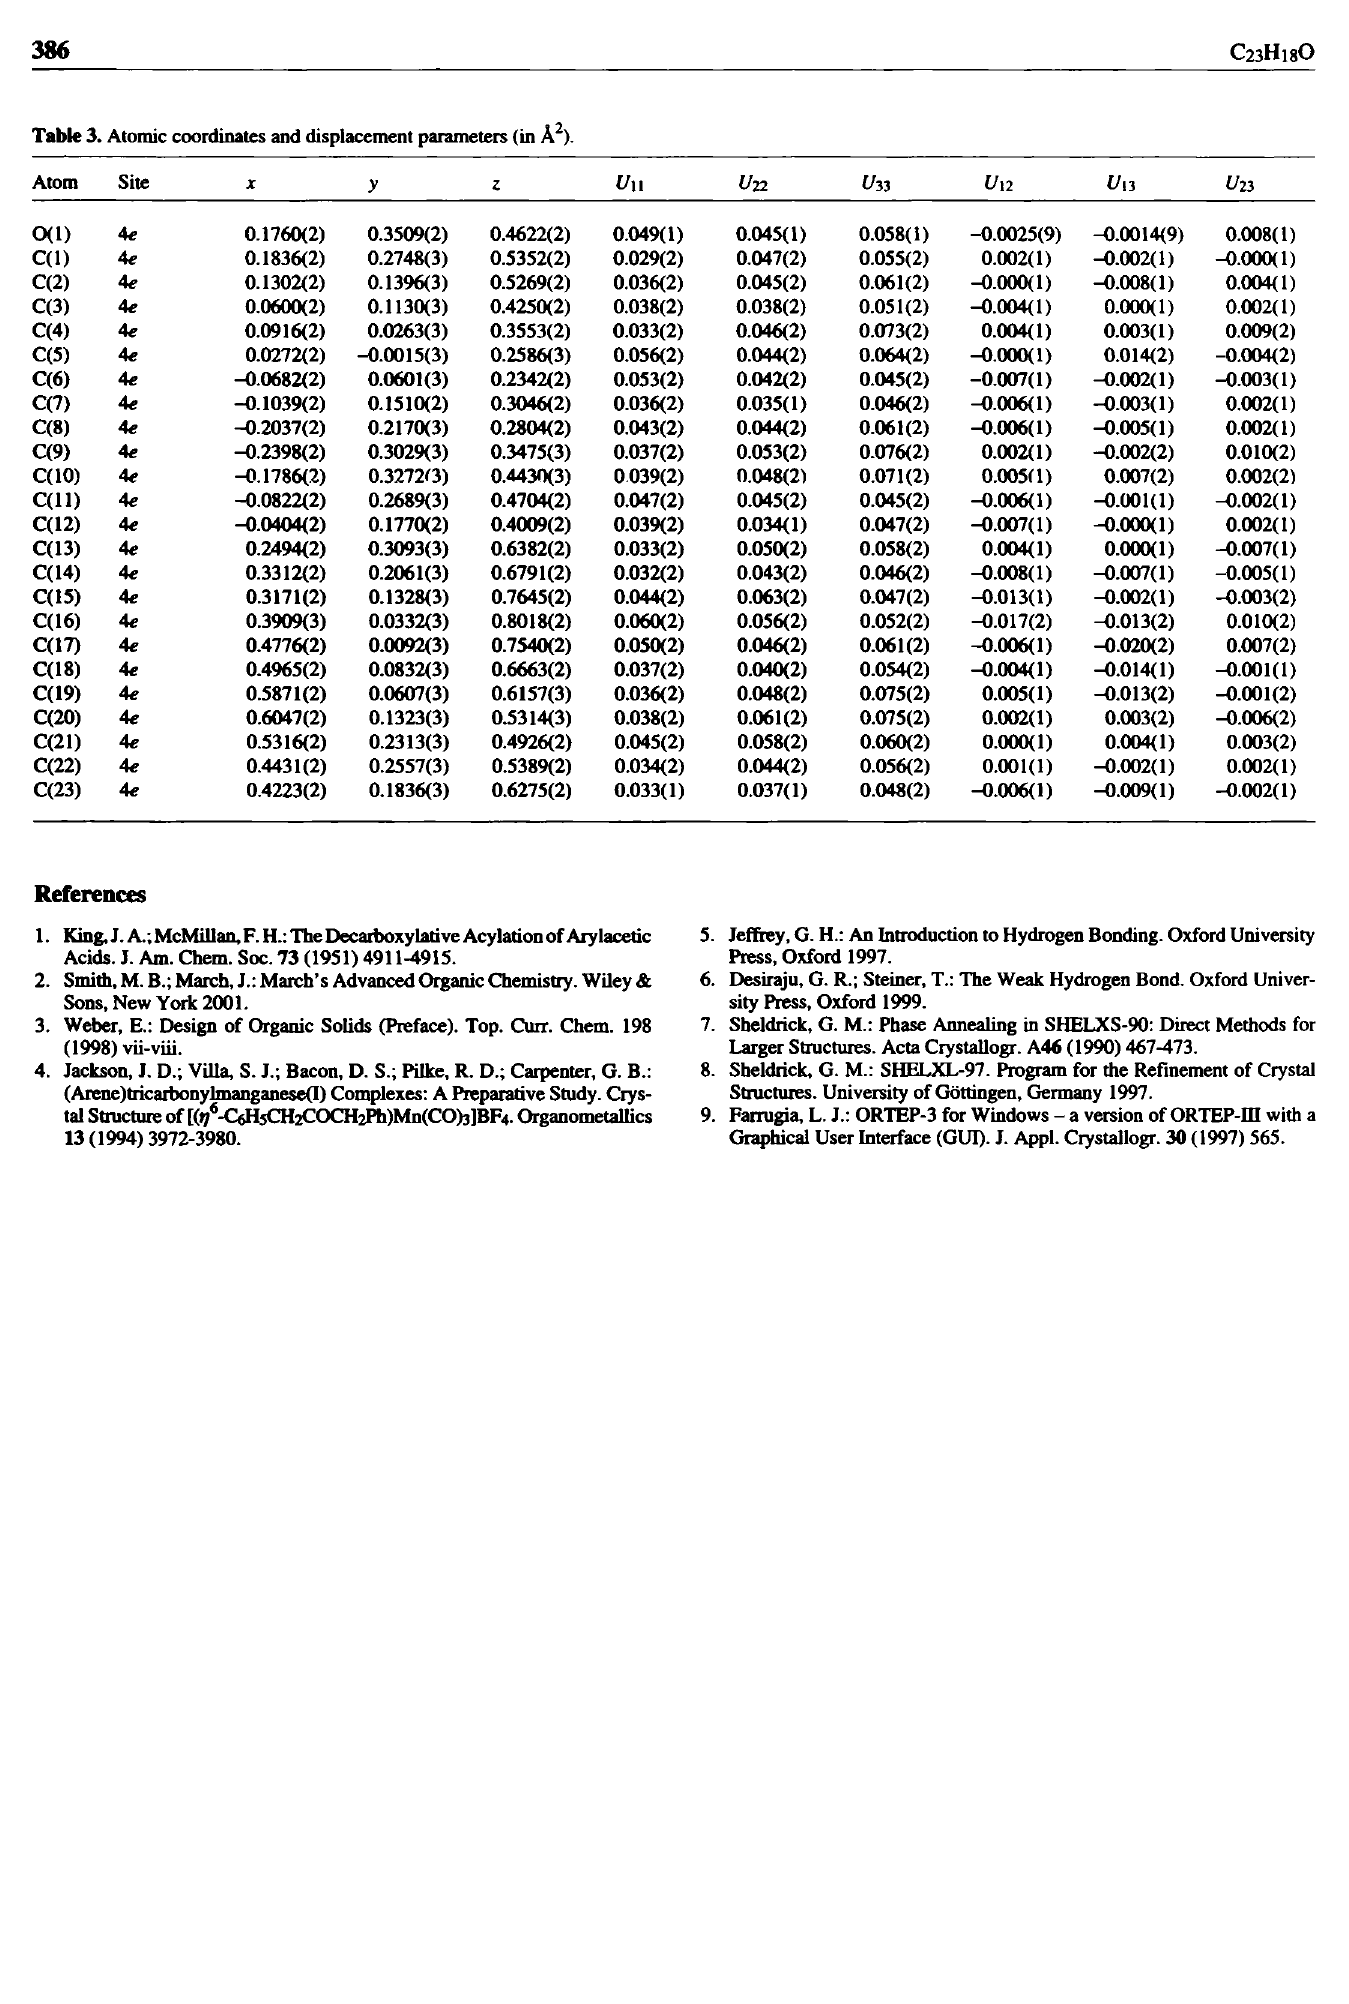
Table 3. Atomic coordinates and displacement parameters (in Ä 2